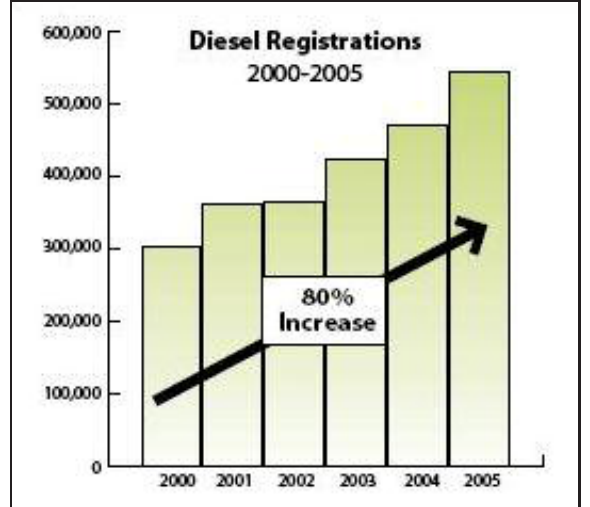
Figure 2. Growth in Diesel Passenger Cars in the United